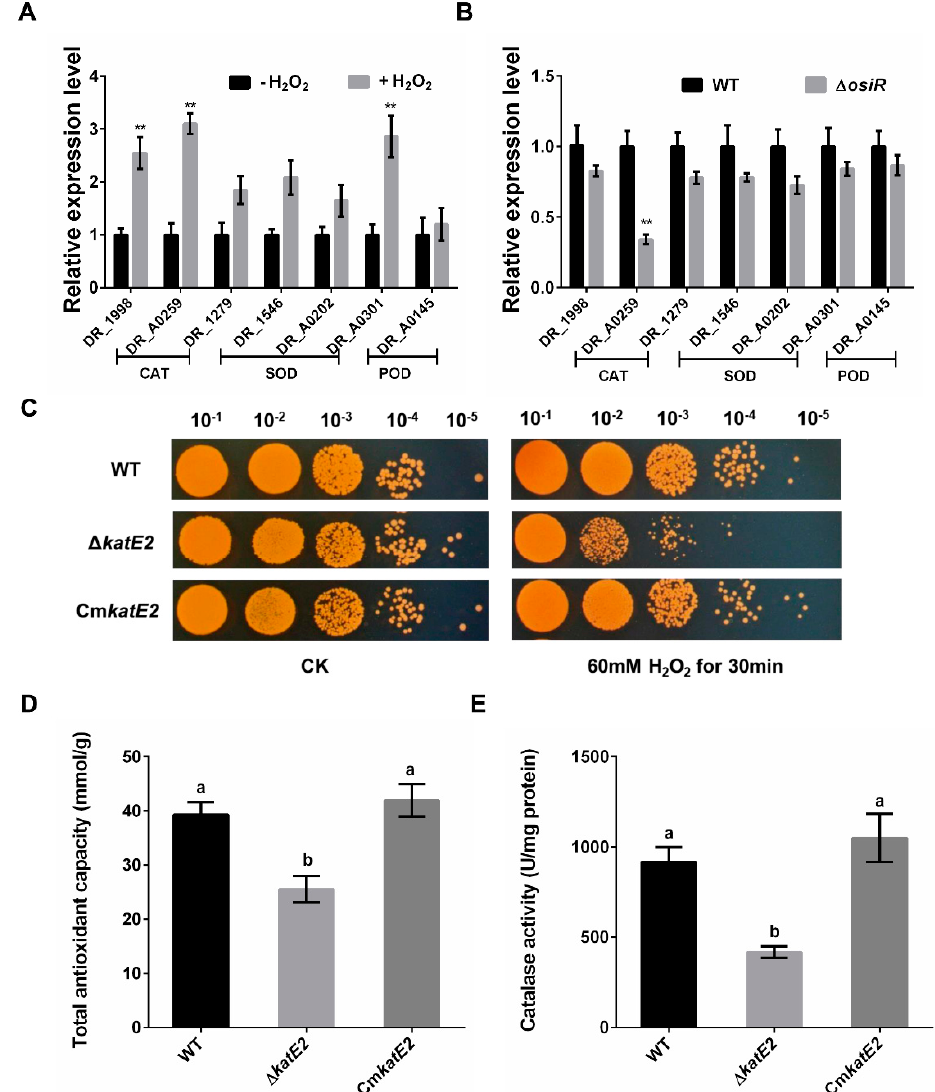
Figure 4. Regulation of OsiR on genes related to oxidative stress resistance and functional analysis of katE2 under oxidative stress. ( A ) expression of seven selected oxidative stress–response genes of D. radiodurans grown in TGY with or without H 2 O 2 ; ( B ) transcript levels of these genes of WT and Δ osiR strains grown in TGY with H 2 O 2 . All experiments were performed three times, and the results are represented as the mean ± standard deviation. Statistical analyses were performed using a Student’s t -test. The statistical significance is indicated as follows: **, p < 0.01; ( C ) survival phenotype plate assay of WT, Δ katE2 and Cm katE2 under oxidative stress conditions; ( D ) and ( E ) effect of katE2 deletion on the total antioxidant capacity and catalase activity of D. radiodurans . The values shown were derived from three independent experiments, and error bars represent standard deviations. The statistical di ff erenceamongthethreesamples(WT, ∆ osiR ,Cm osiR )wasdeterminedbyTukeymultiplecomparisons ( p < 0.05); the same letter indicates that the di ff erence is not significant and di ff erent letters indicate significant di ff